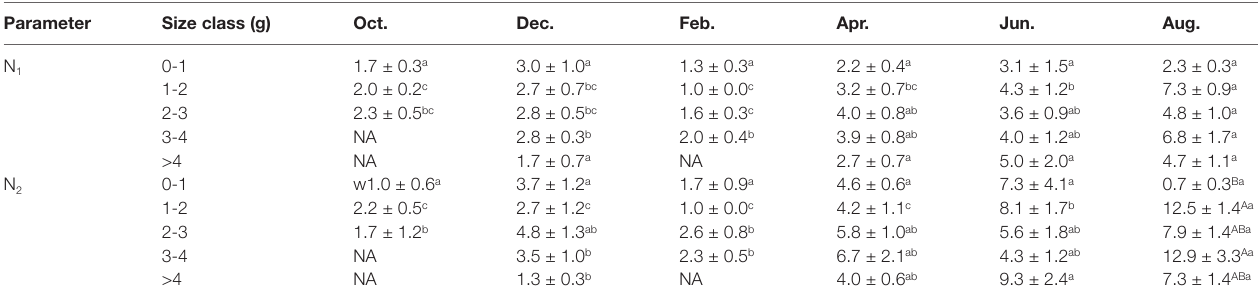
TABLE 2 | The number of P. aibuhitensis burrow openings (N 1 ) and burrow branches (N 2 ) for different size classes and sampling months (mean ± S.E).